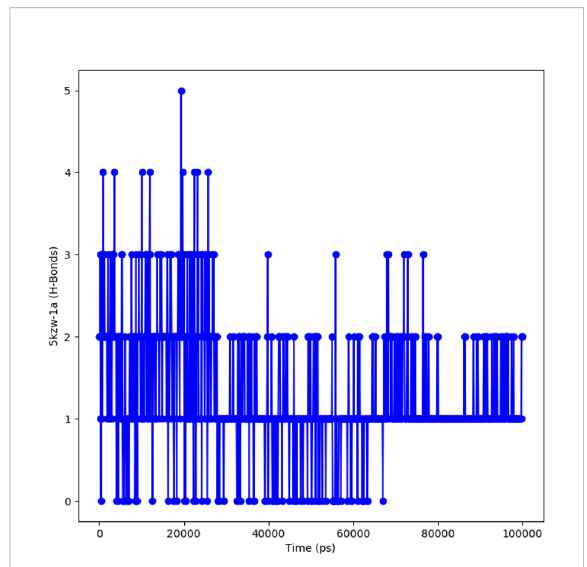
FIGURE 9 Representation of hydrogen bonding pattern observed for protein ligand complexes (adapalene-red and tamsulosin-blue) for 100 ns MD